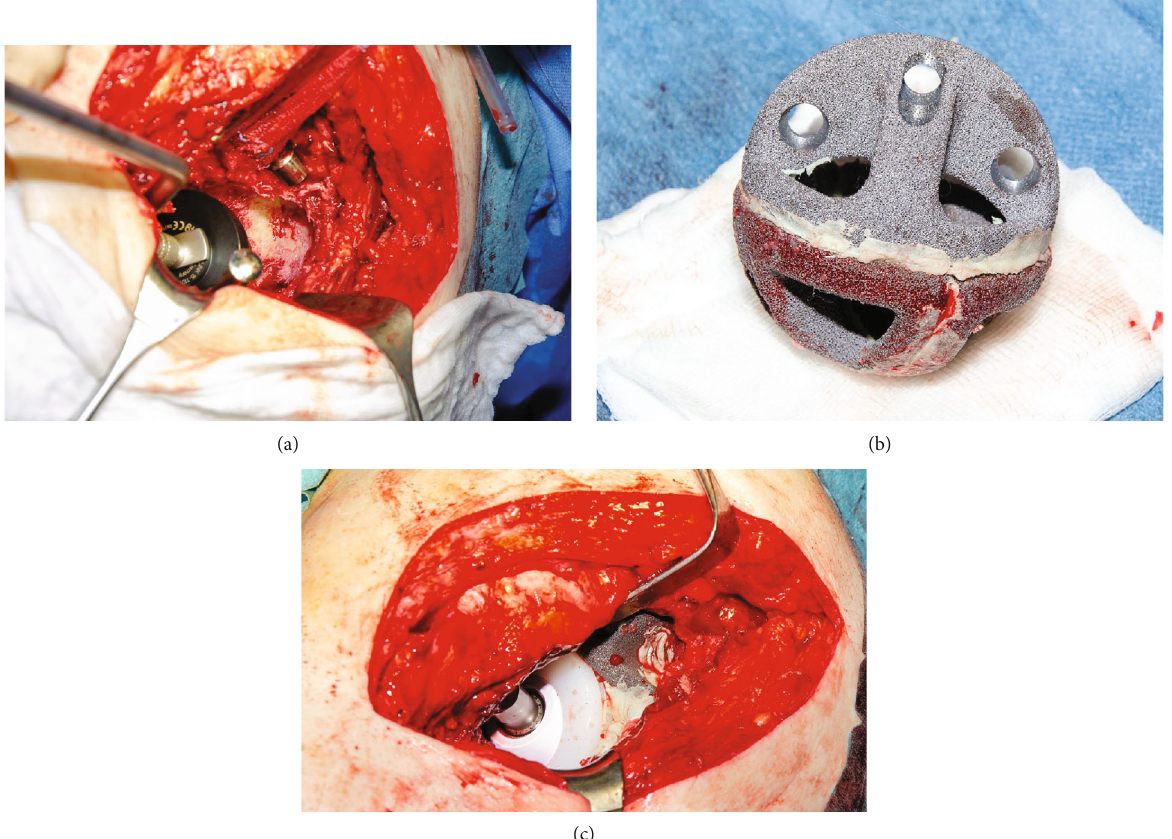
Figure 2: (a) Intraoperative photo of the acetabulum with the trial cup in situ in the original hip center. Large secondary spherical bone defect evident overlying the previous pseudoarthrosis. (b) Intraoperative photo using three tantalum augments and cementing them together in a “ football con fi guration. ” (c) Intraoperative photo showing the tantalum augments in situ fi lling the cranial acetabular defect. Underneath, we see the cemented Mark III cup with the ceramic head.